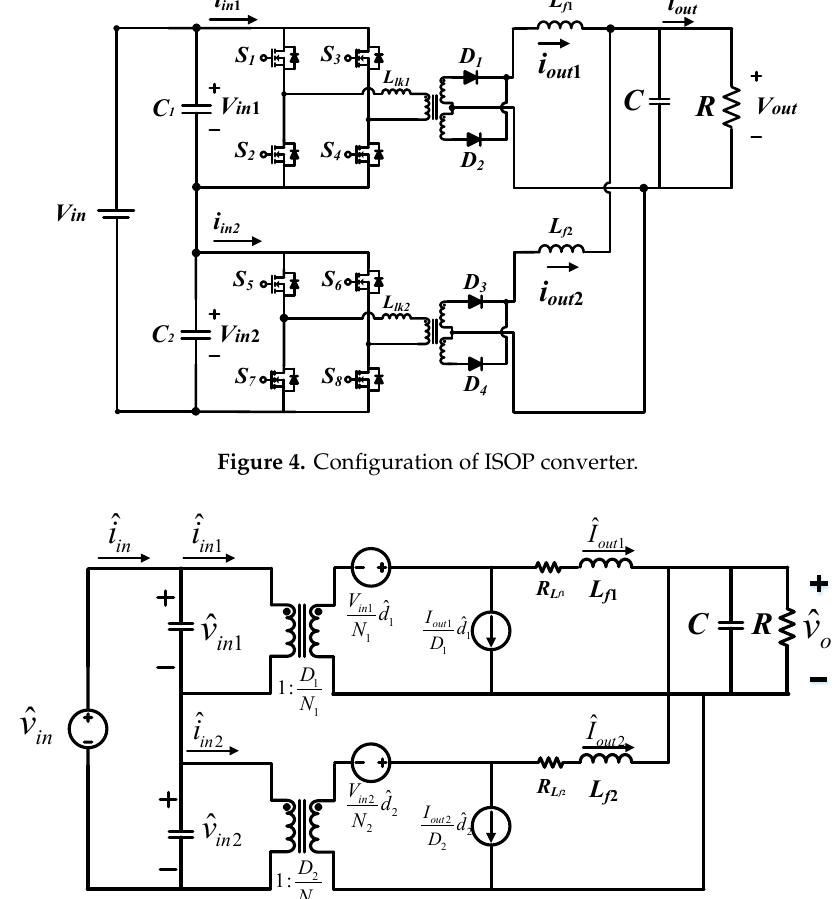
Figure 5. Small signal equivalent circuit model of ISOP converter.